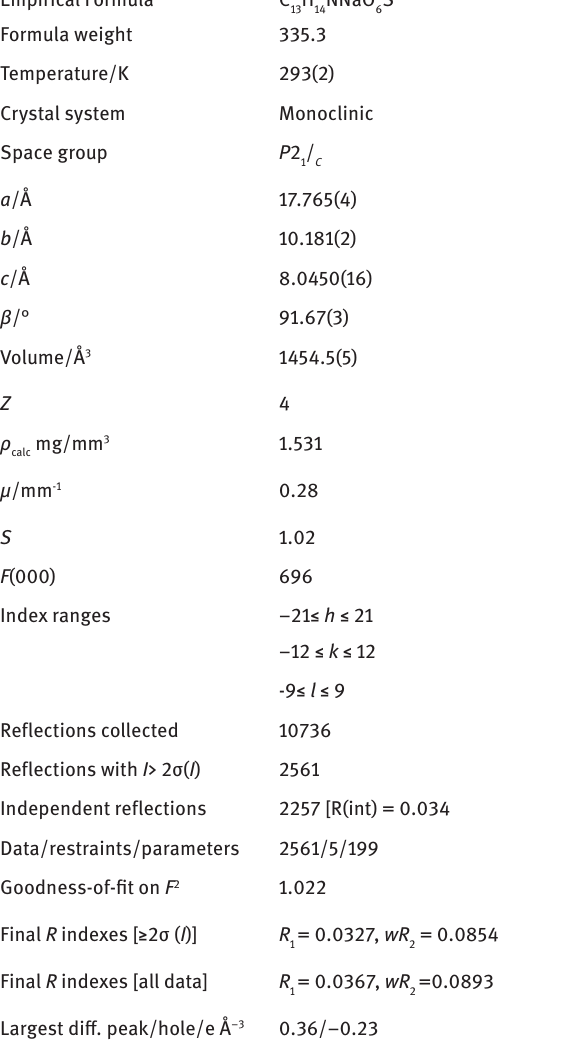
Table 1: Crystal data for 1